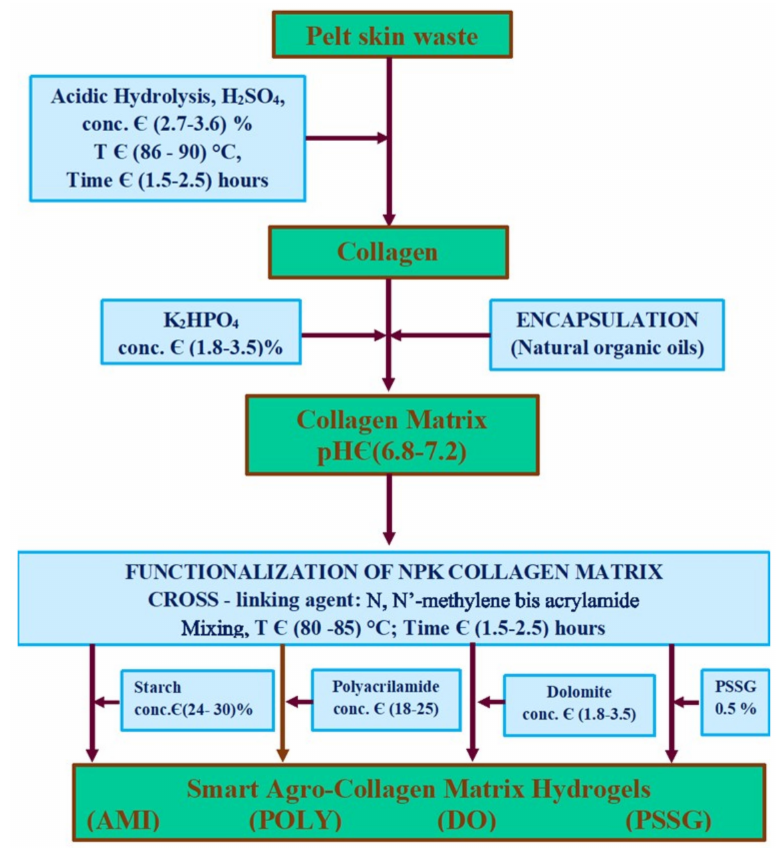
Figure 2. Technology scheme for obtaining smart-fertilizers by using acid hydrolysis,